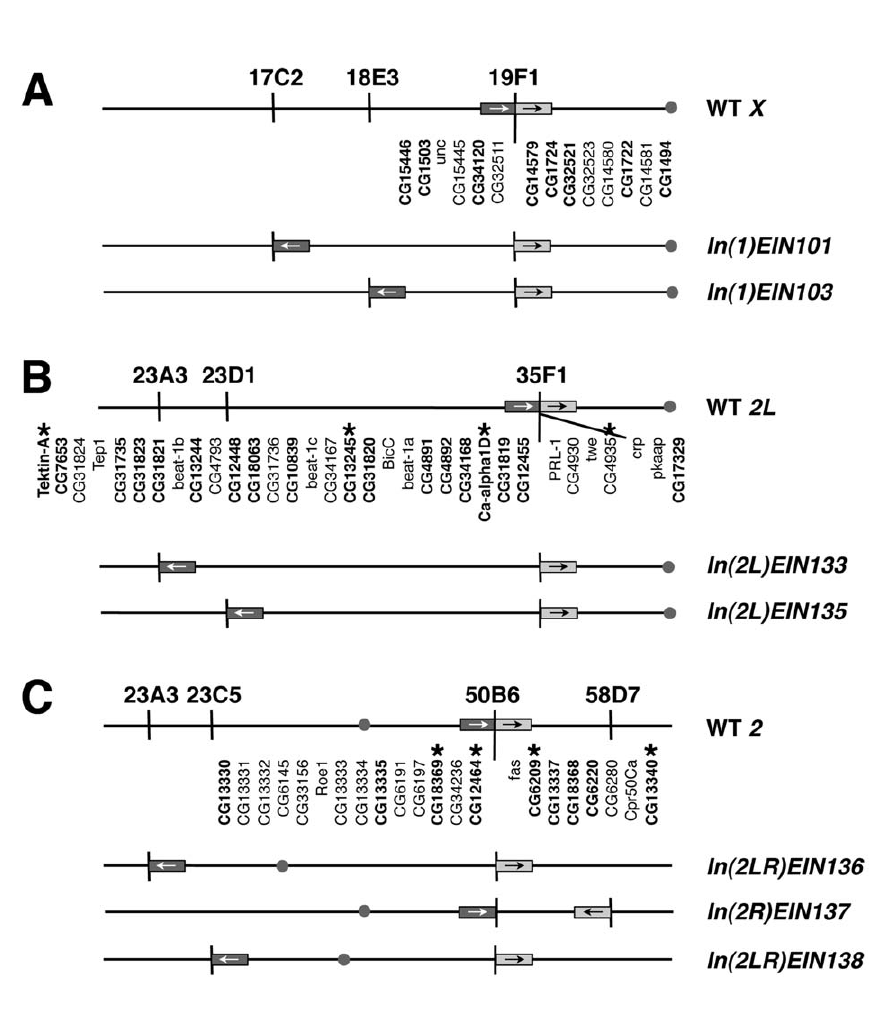
Figure 1. Inversions disrupting male-specific gene expression neighbourhoods. Diagrammatic representation of the seven inversions generated in three expression neighbourhoods. (A) Inversions in the X chromosome neighbourhood at 19F. (B) The Chromosome 2L inversions disrupt the 35F neighbourhood. (C) Inversions disrupting the chromosome 3R neighbourhood at 50B. Each of the three neighbourhoods is represented by the shaded boxes with the arrows indicating relative orientation. The genes in the neighbourhood are indicated underneath with bold text indicating male elevated expression; the gap represents the location of the breakpoint in each neighbourhood. Note that the inversions in the 35F region have two different breakpoints. The chromosomal location of each breakpoint is indicated below the wild type chromosome cartoon. Below the wild type, the structure of each inversion is diagrammed to show how the relative position and orientation of genes in the neighbourhood changes. The grey circles represent the centromeres and the stars represent genes assayed by